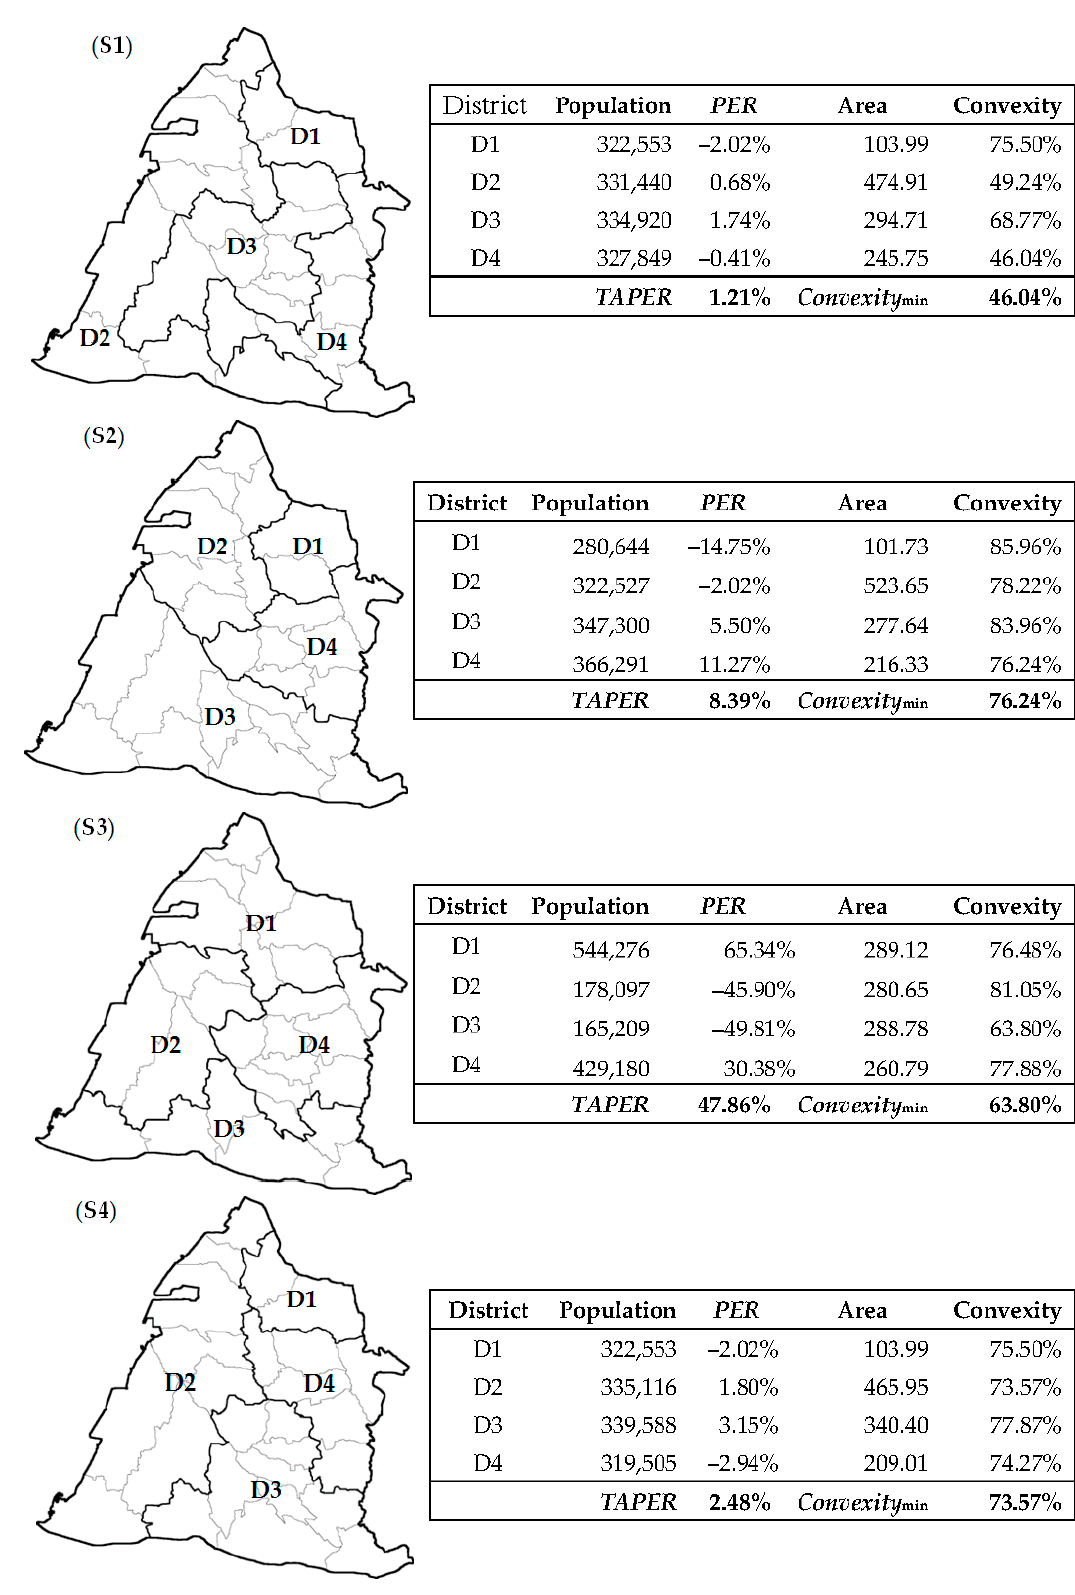
Figure 8. Some partition cases obtained from computation. Corresponding to the serial number on the map, they are labeled as S1, S2, S3, and S4.